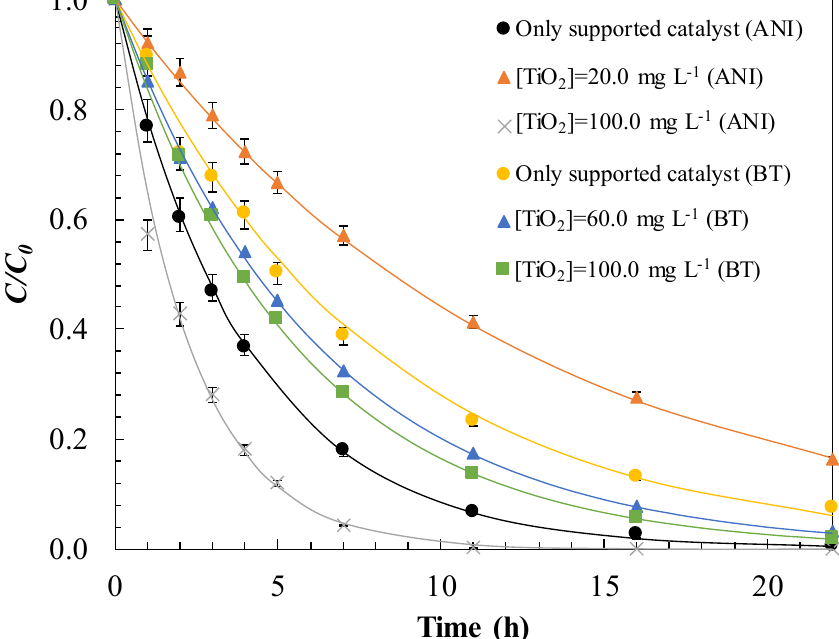
Figure 10. Comparison between only supported and suspended-supported TiO 2 for the degradation of: aniline or benzothiazole, through the experimental (dots) and modelled ( ——— ) pseudo-first order kinetics. Experimental conditions: C 0 = 22.0 mg L − 1 ; pH = 12.0 (aniline); pH = 8.0 (benzothiazole); T = 25.0 °C; P = 1.0 atm.